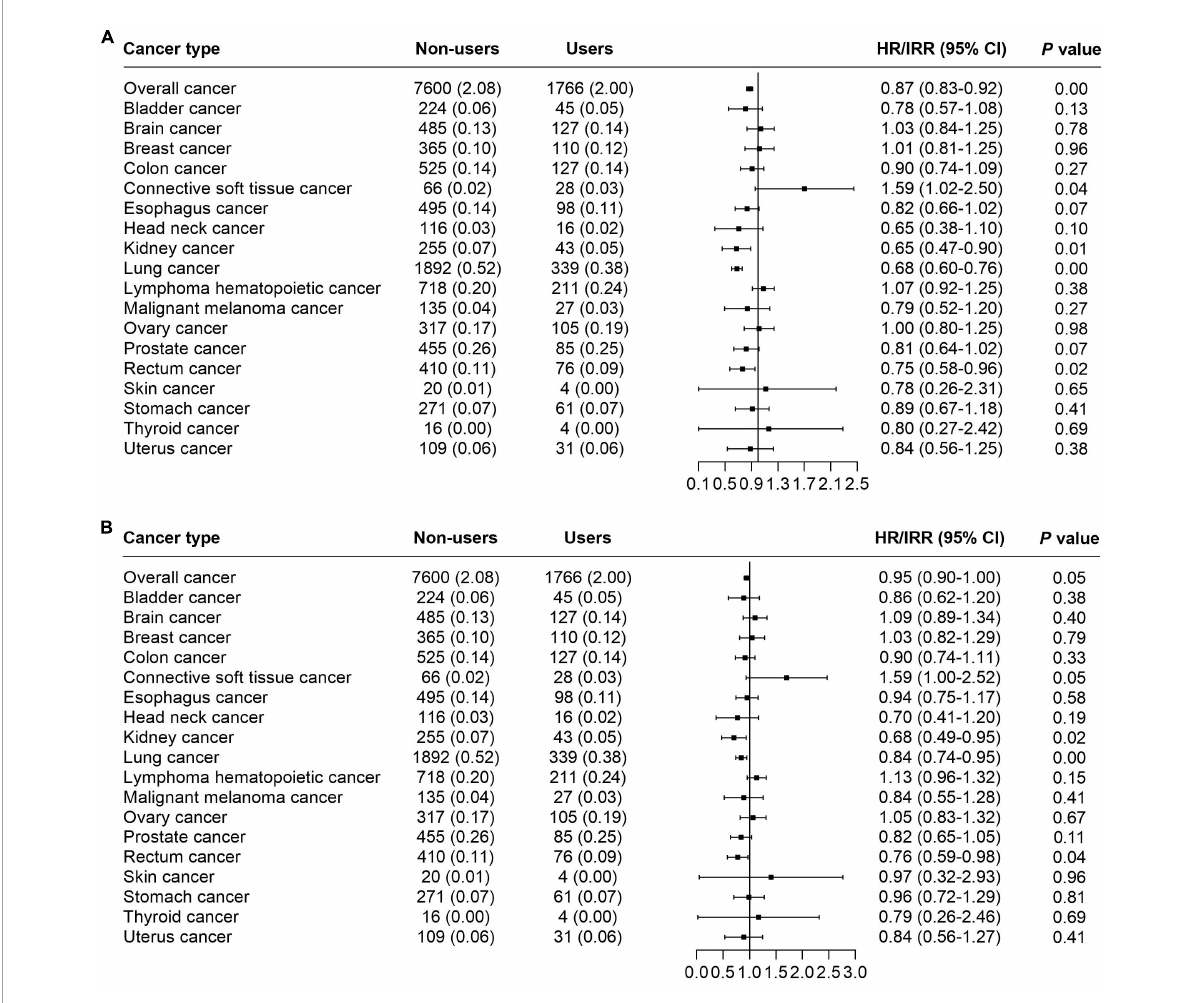
FIGURE2 The forest plot indicating the correlation of habitual use of glucosamine and cancer mortality. (A) Basic model adjusted by age, gender, ethnic, and average total household. (B) Adjusted model performed via adjusting of age, gender, ethnic background, average total household income, obesity, physical activity, current smoking, alcohol intake, minerals supplementation, fruit intake, vegetable intake, processed meat intake, red meat intake, aspirin use, NSAIDS use, chondroitin use, and vitamin use.